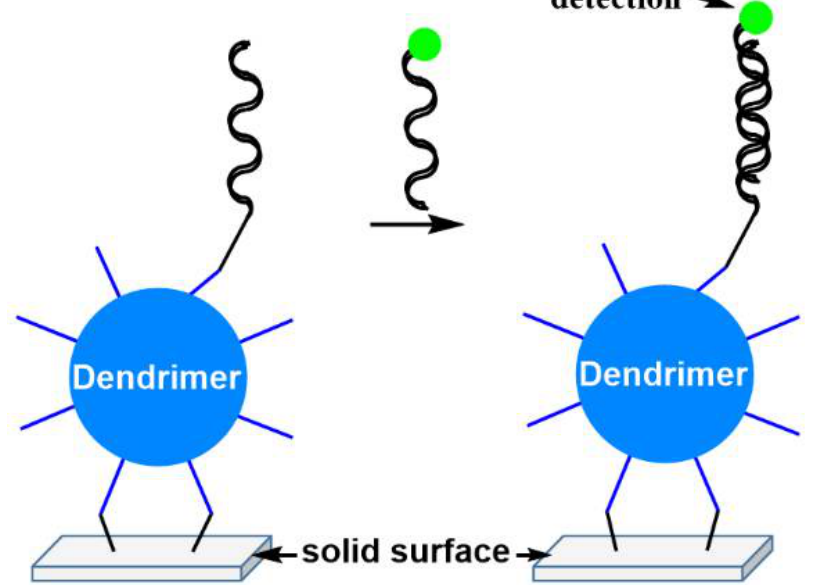
Figure 8. Principle of the use of dendrimers in bioassays.